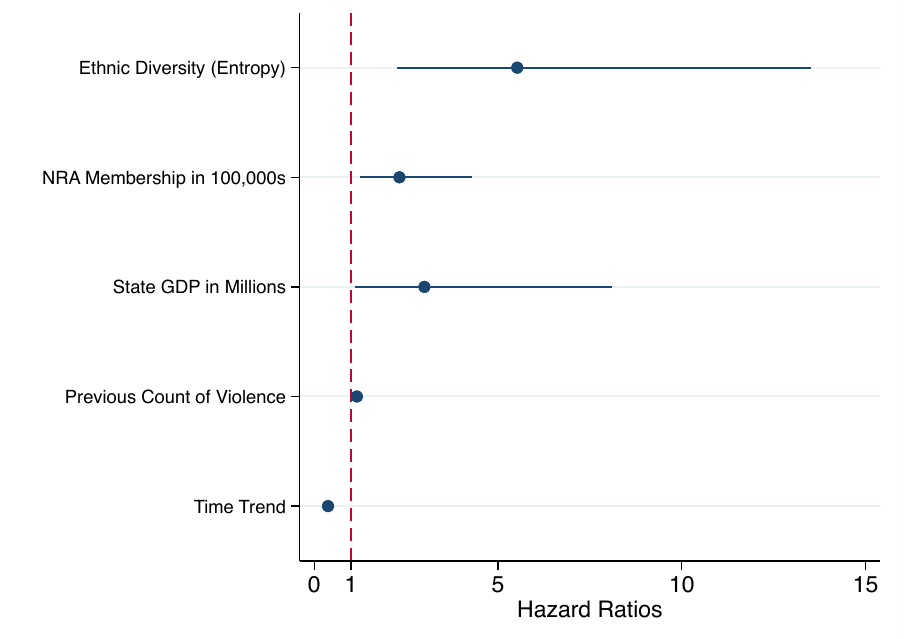
Figure 3: Effects on the hazard of right-wing violence in U.S. states, 2000 through 2018 (estimates from Table B1, column